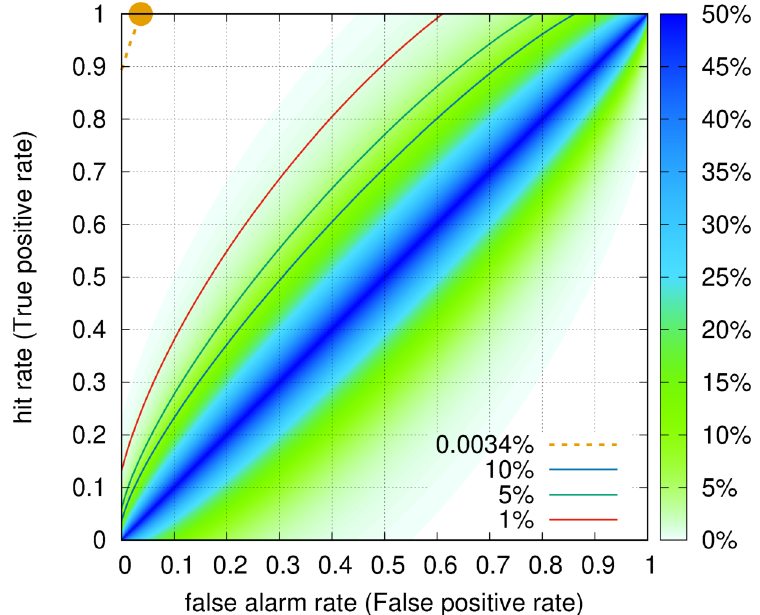
Figure 11. Receiver Operating Characteristics diagram for the results after applying DFA. The orange circle signifies the corresponding operation point and the orange dashed line the k -ellipse corresponding to p = 0.0034%. The colored contours represent the p -value to obtain by chance an ROC point based on the k -ellipses, with the darkest blue in the diagonal corresponding to random predictions. The k -ellipses with p = 10%,5%,1% are also